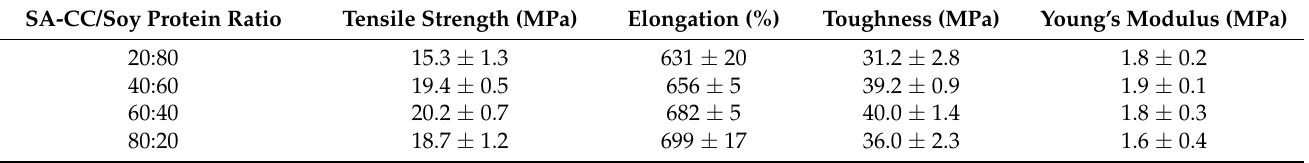
Table 2. SA-CC/soy protein ratio comparison.